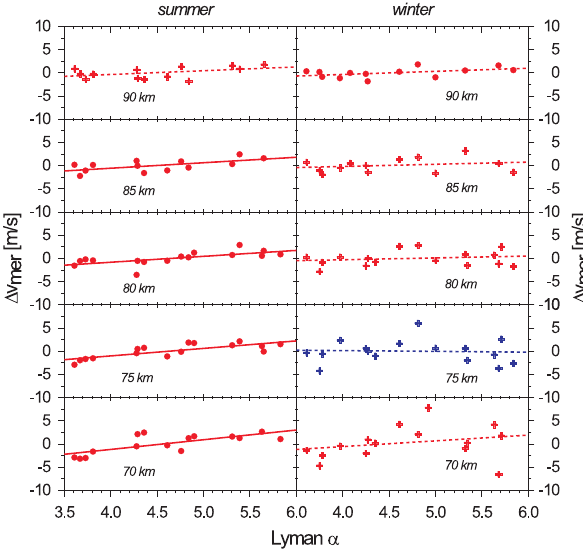
Fig. 9. Dependence of detrended meridional wind values at Julius- ruh on solar activity for summer and winter conditions at different heights. Positive relations are red, negative relations blue. Signif- icance levels are characterized by full lines and dots ( χ ≥ 95%) or dashed lines and dots ( χ ≥ 90%), nonsignificant levels by dashed lines and crosses ( χ<